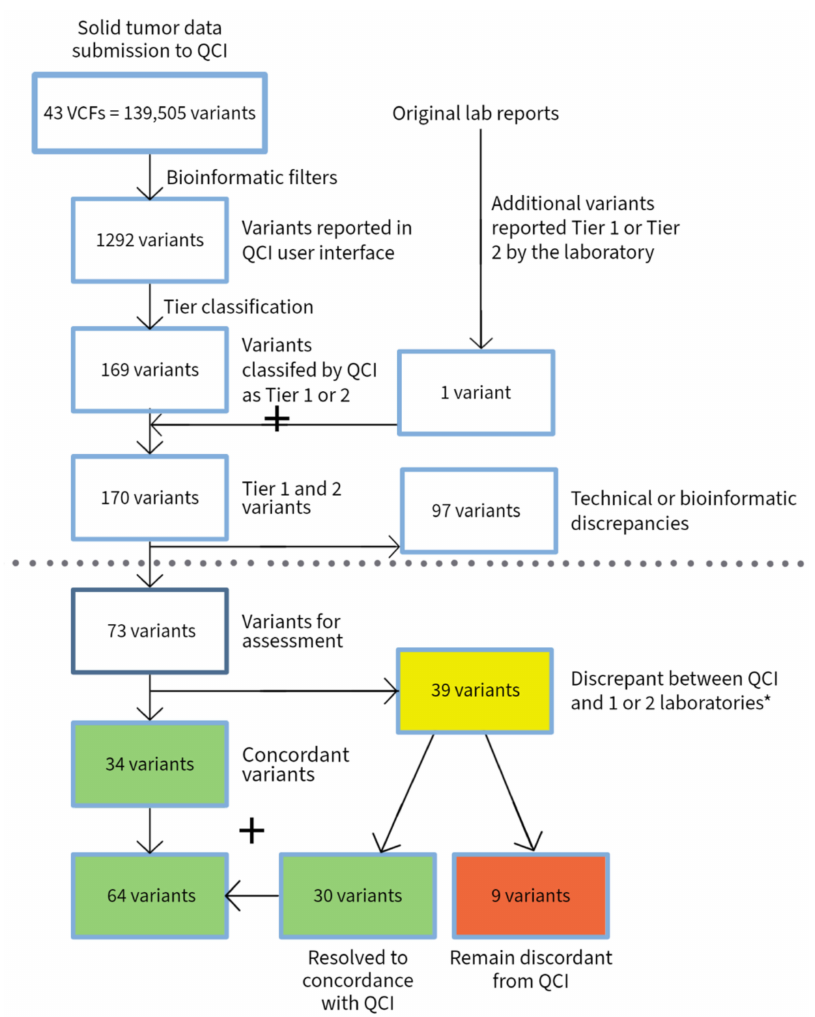
Figure 3. Flow diagram of data from solid tumors. * Discrepancy between laboratories 1 and 2 may indicate agreement with QCI from at least one